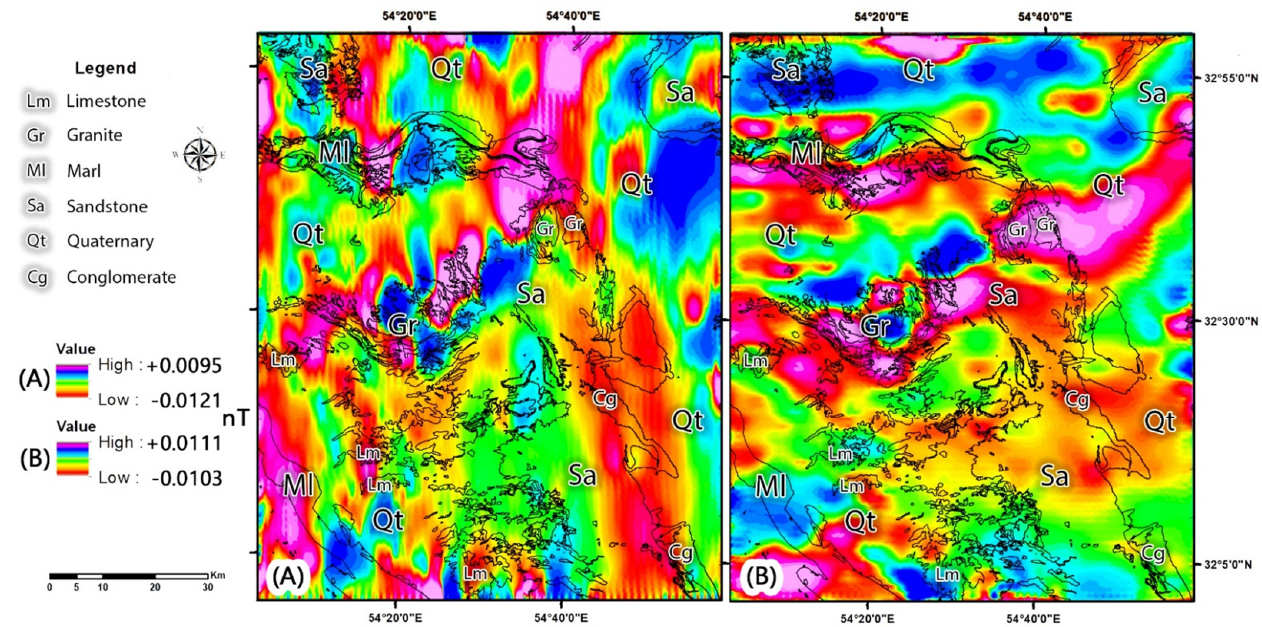
Figure 9. Horizontal derivative map for the study area. ( A ) horizontal derivative filter in the direc- tion of 45-degree azimuth; ( B ) horizontal derivative filter in the direction of 135-degree